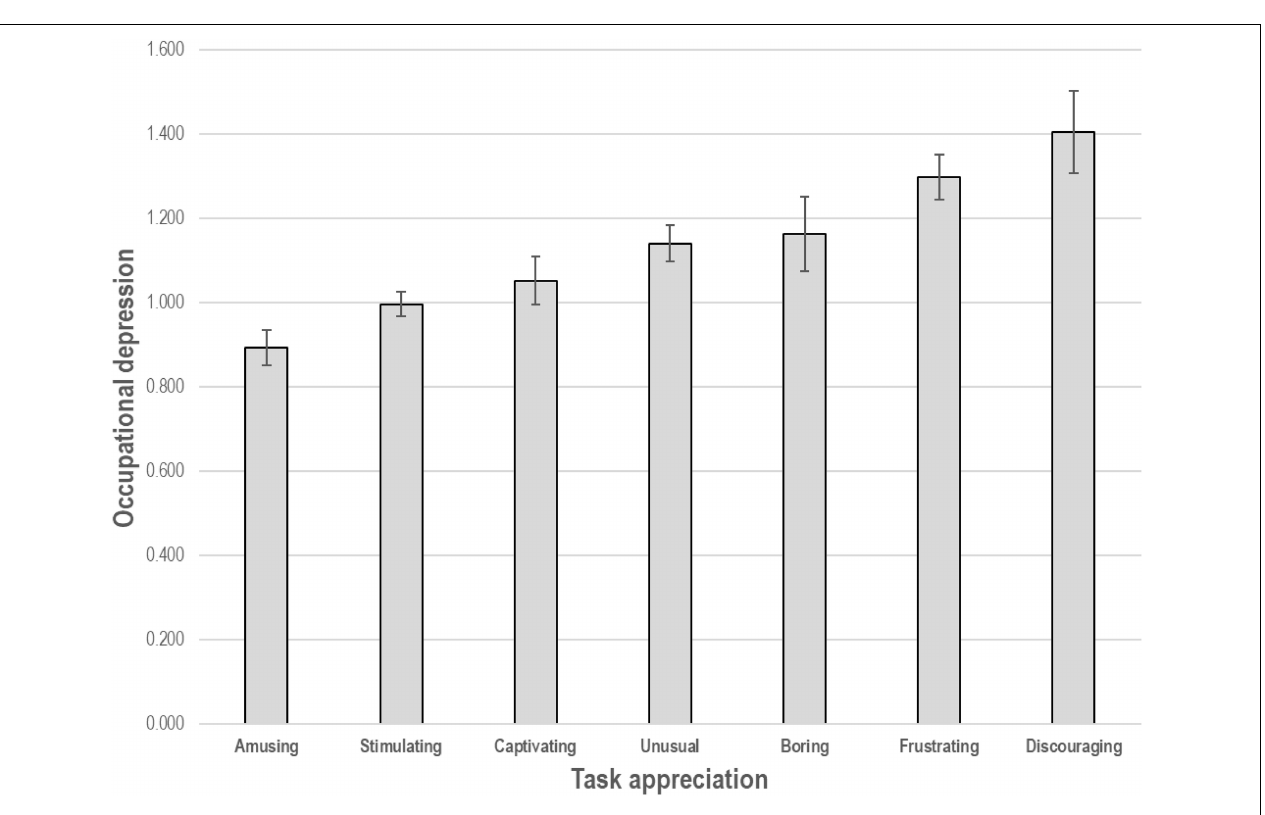
FIGURE 3 | Mean score on the Occupational Depression Inventory ( ± 1 standard error) per task appreciation